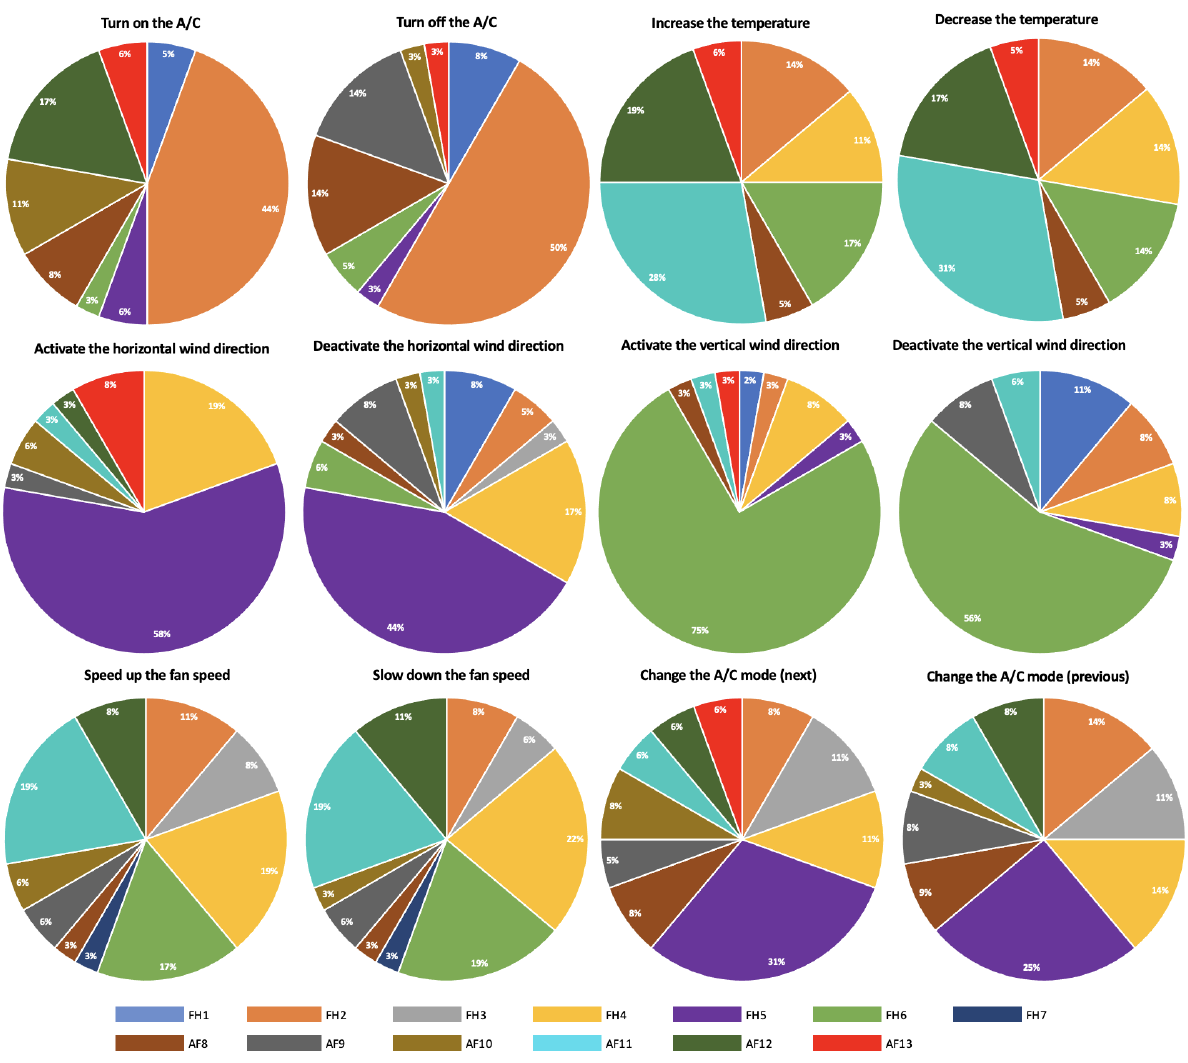
Figure 9. The gesture distribution based on CrossG vocabulary for each of the 12 AC